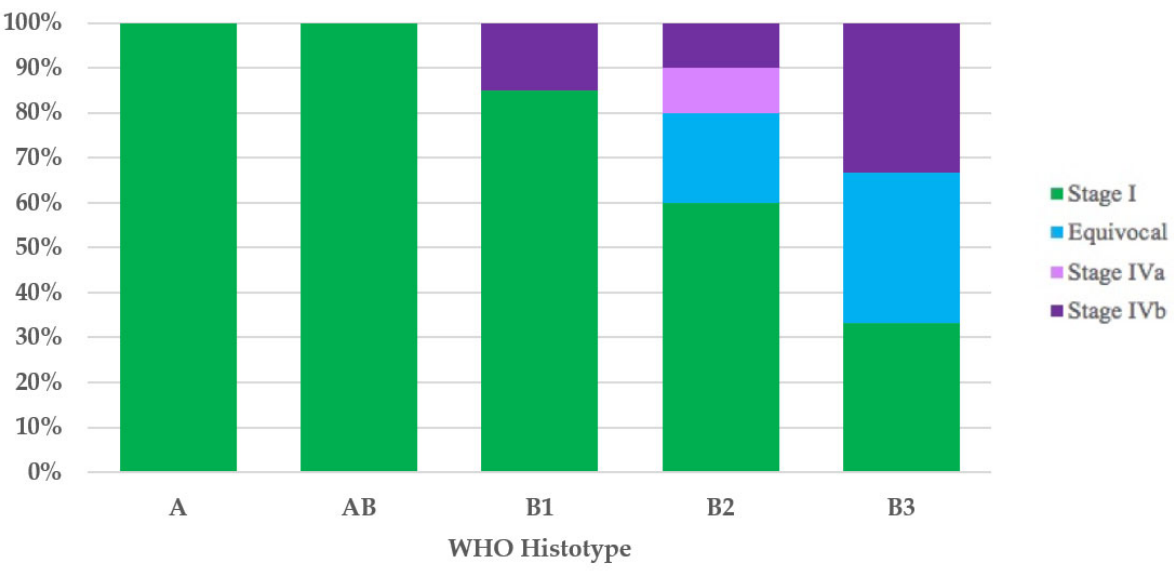
Figure 2. Stage distribution in thymoma histotypes according to the UICC/AJCC TNM stage classification. UICC/AJCC TNM, Union for International Cancer Control/American Joint Committee on Cancer Tumor–Node–Metastasis; WHO, World Health Organization.